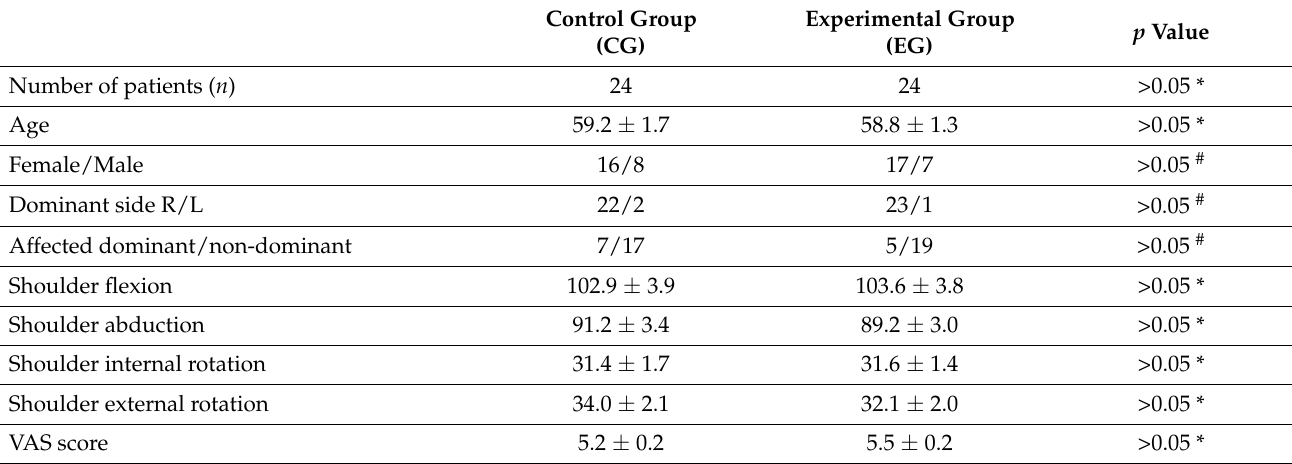
Table 1. Demographic Features, range of motion (ROM), and visual analogue scale (VAS) score at baseline assessment. Control